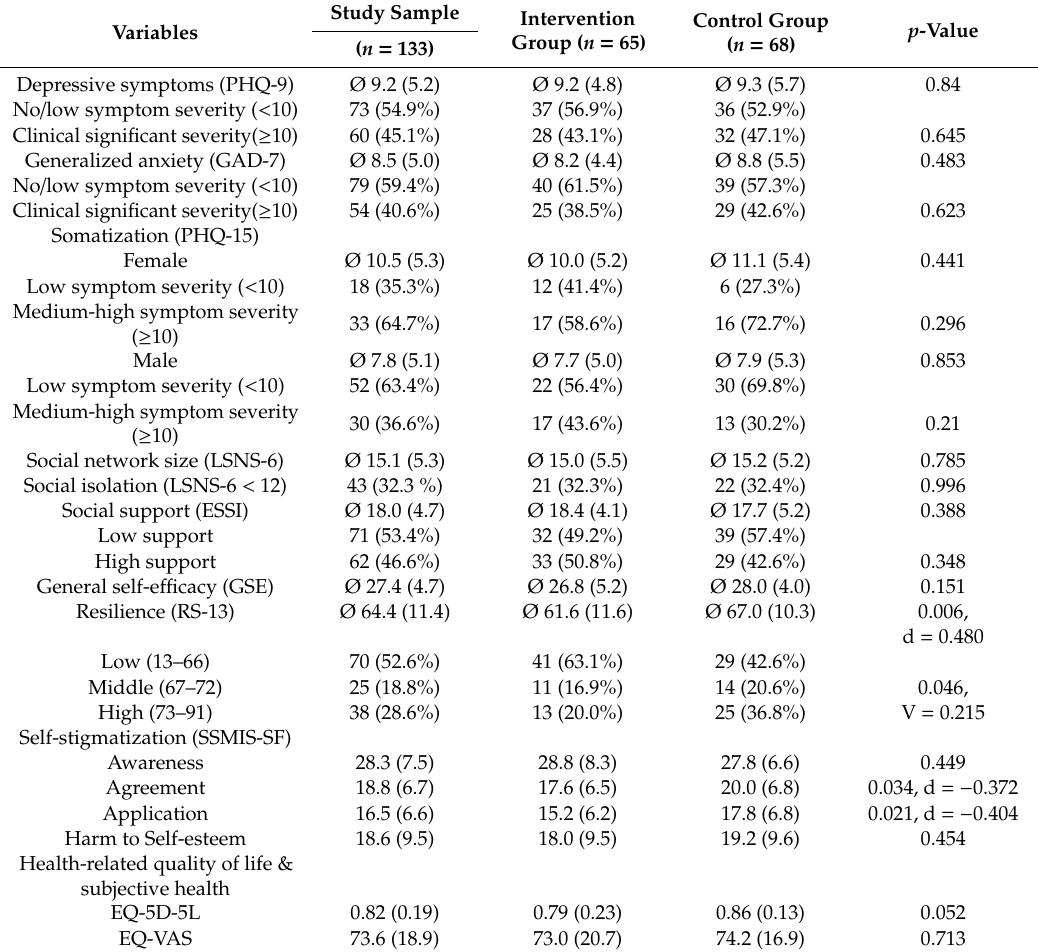
Table 6. Secondary characteristics of the “Sanadak” study sample with regard to group